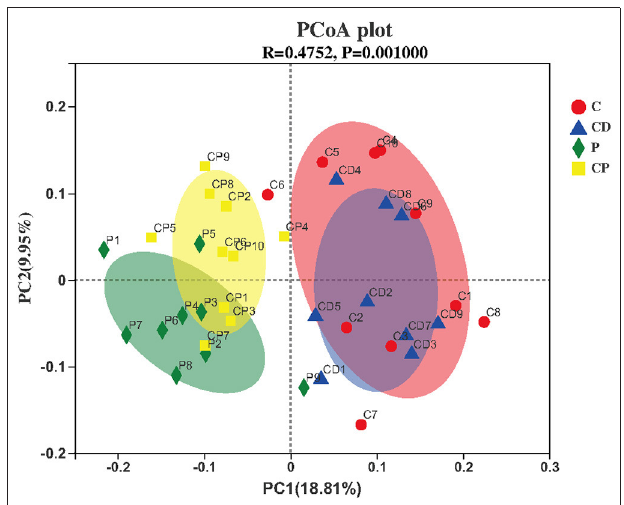
FIGURE 5 | Principal coordinate analysis (PCoA) and plot analysis of different treatment groups ( n = 10).